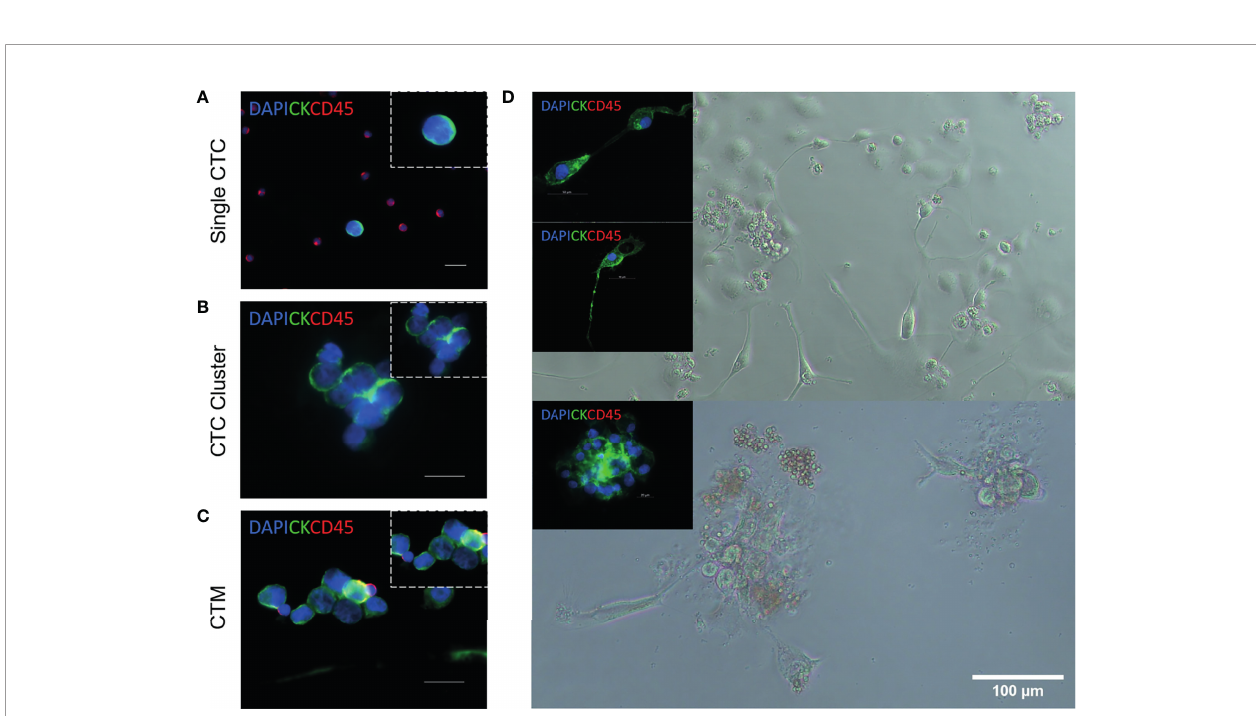
FIGURE 2 | Circulating tumour cell isolation, expansion, and characterization from patients with NSCLC (18). Representative images of single circulating tumour cells (CTCs) (A) , CTC clusters (B) , and circulating tumour microemboli (CTM) (C) . Immuno fl uorescent staining using anti-CK-FITC, anti-CD45-APC, and DAPI. Scale bar represents 20 m m. (D) Isolation, expansion, and characterization of CTCs from patients with advanced-stage NSCLC. Cultured CTCs derived from patient blood samples in a 96-well standard microplate. In-well staining of proliferating cells in culture at day 7. Immuno fl uorescent staining using anti-CK-FITC and anti-CD45- APC. Cells were shown to be CD45 negative.